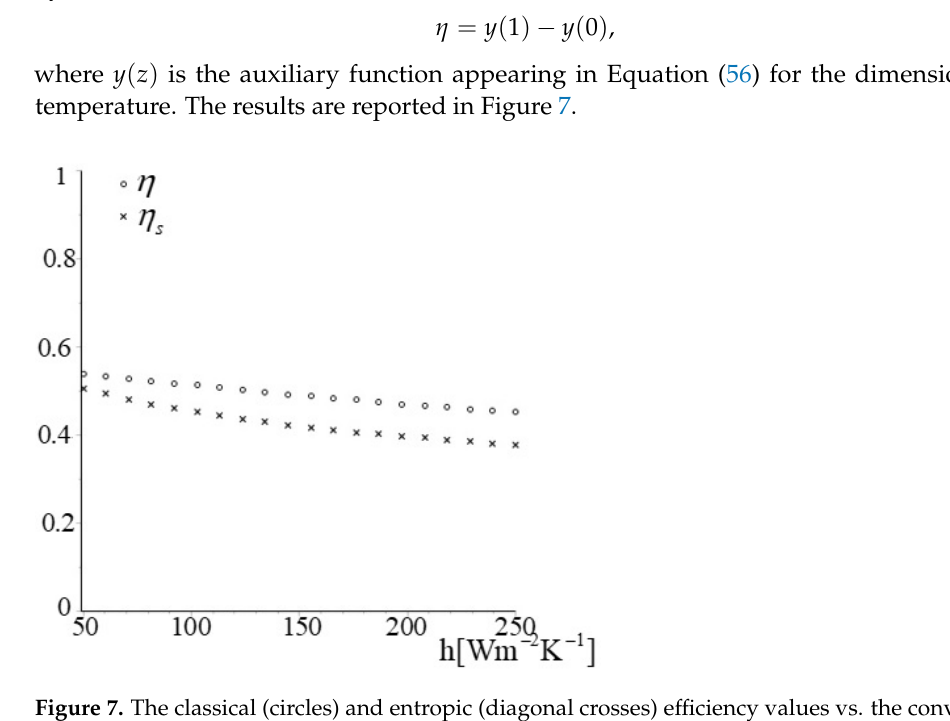
Figure 7. The classical (circles) and entropic (diagonal crosses) efficiency values vs. the convective heat transfer coefficient for the example of an aluminum